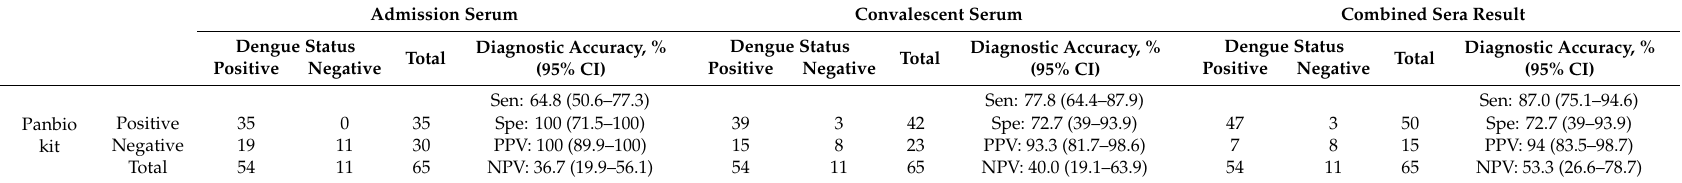
Table 2. Accuracy of Panbio ELISA for dengue diagnosis for patients from Panel A.